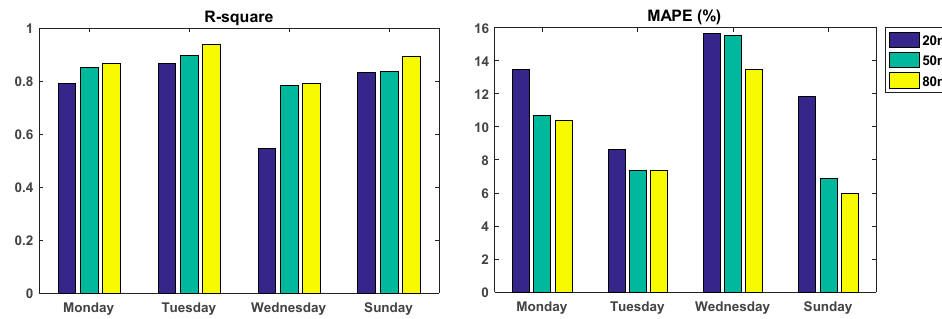
Figure 11. The value of R-squared and MAPE for the combined model ELM–Elman–LSTM.